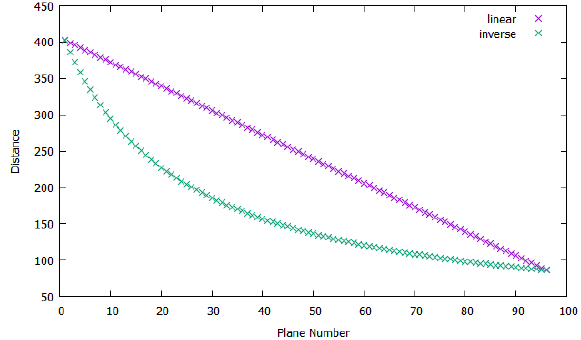
Figure 5. Comparison between linear and inverse sampling in scene space.